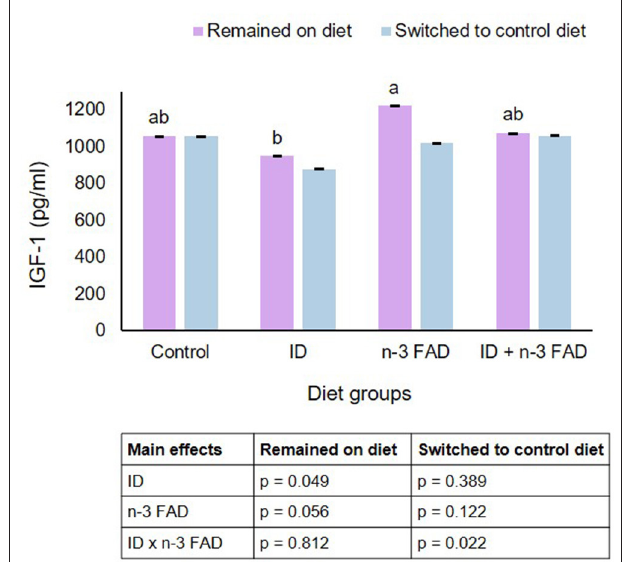
FIGURE 3 | Insulin-like growth factor-1. Two-way ANCOVA was used to test effects of ID, n-3 FAD, and ID x n-3 FAD interactions, adjusted for sex and body weight. IGF-1 was log transformed to perform ANCOVA. Between-group differences were determined using one-way ANCOVA followed by Bonferroni’s post-hoc test (adjusted for sex and body weight). Means with superscripts without a common letter differ ( P < 0.05). ID, iron deficiency; n-3 FAD, omega-3 fatty acid deficiency; IGF-1, insulin-like growth